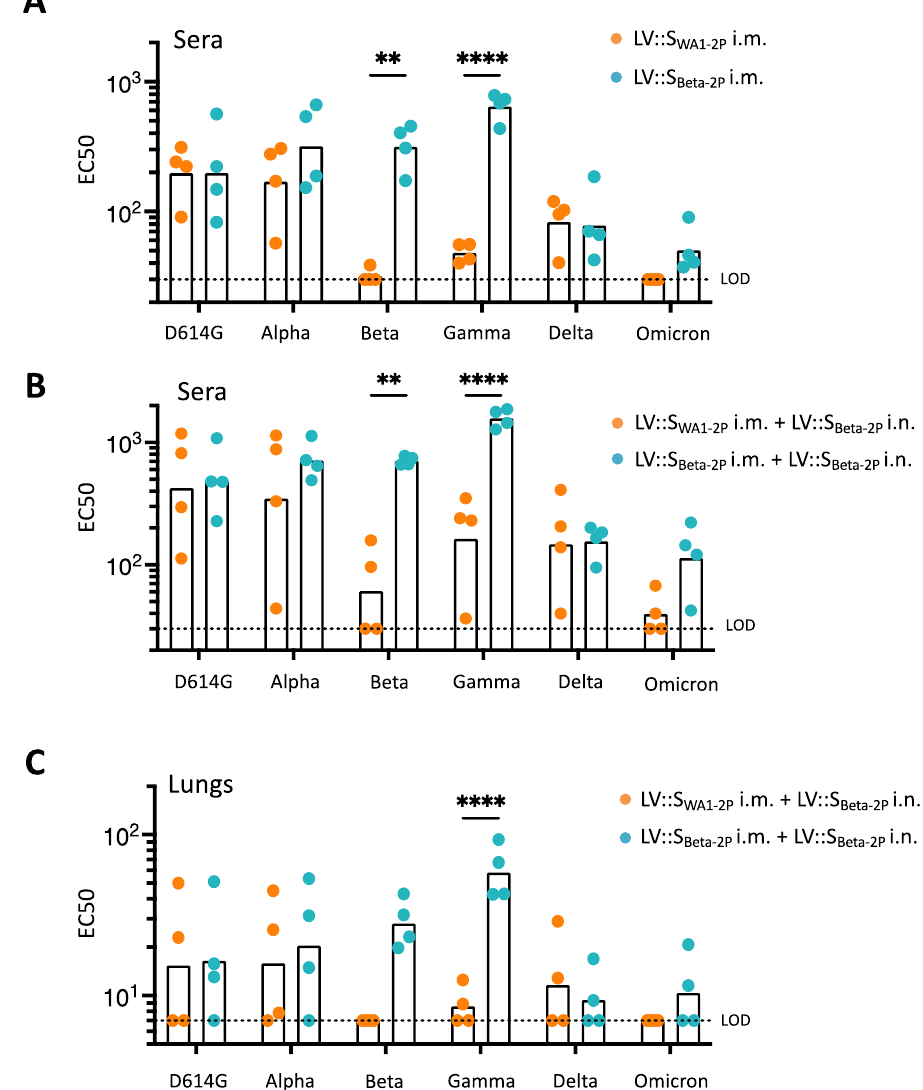
Figure 8. Anti-S CoV-2 antibody imprinting in hamsters vaccinated by LV::S prime (i.m.)-LV::S Beta-2P boost (i.n.). Hamsters are those described in the legend to Figure 7. ( A – C ) EC50 determined by use of pseudo-viruses carrying S CoV-2 from the D614G, Alpha, Beta, Gamma, Delta or Omicron variants. EC50 ( A ) 5 wks post-prime in sera or 2 wks post-boost in sera ( B ) and in lung homogenates ( C ). Data are expressed as the geometric mean EC50. Statistical significances were analyzed using two-way ANOVA followed by Sidak’s multiple comparisons test; ** p < 0.01; **** p < 0.0001. Dotted lines indicate the lower limit of detection (LOD).